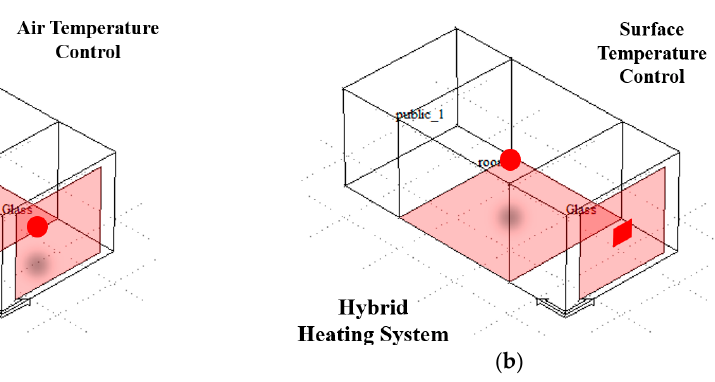
Figure 12. Heating surface and temperature sensing point of hybrid heating systems. ( a ) Air-temperature sensing model; ( b ) Surface-temperature sensing model.